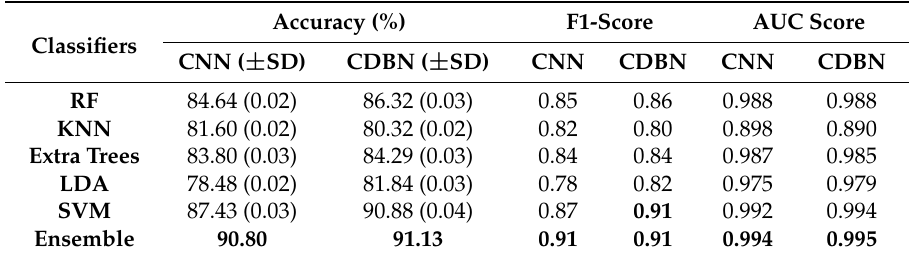
Table 2. Best performances of various classifiers on CNN and CDBN feature extracted from 3x_Aug dataset with FDAP. Bold numbers mark the highest score of the algorithm(s) for learned features from